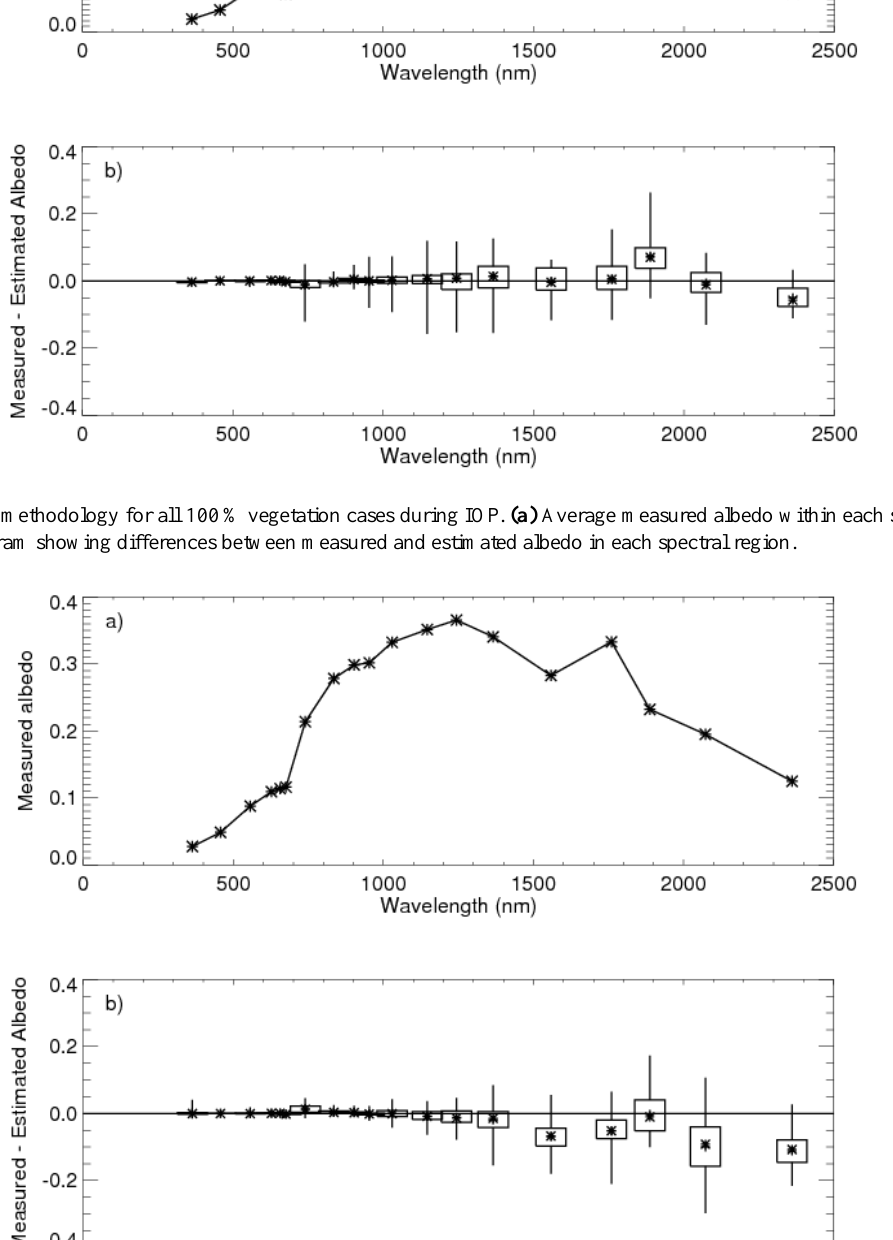
Fig. 8. Evaluation of methodology for all partially vegetated cases during IOP. (a) Average measured albedo within each spectral region and (b) box-whisker diagram showing differences between measured and estimated albedo in each spectral region.